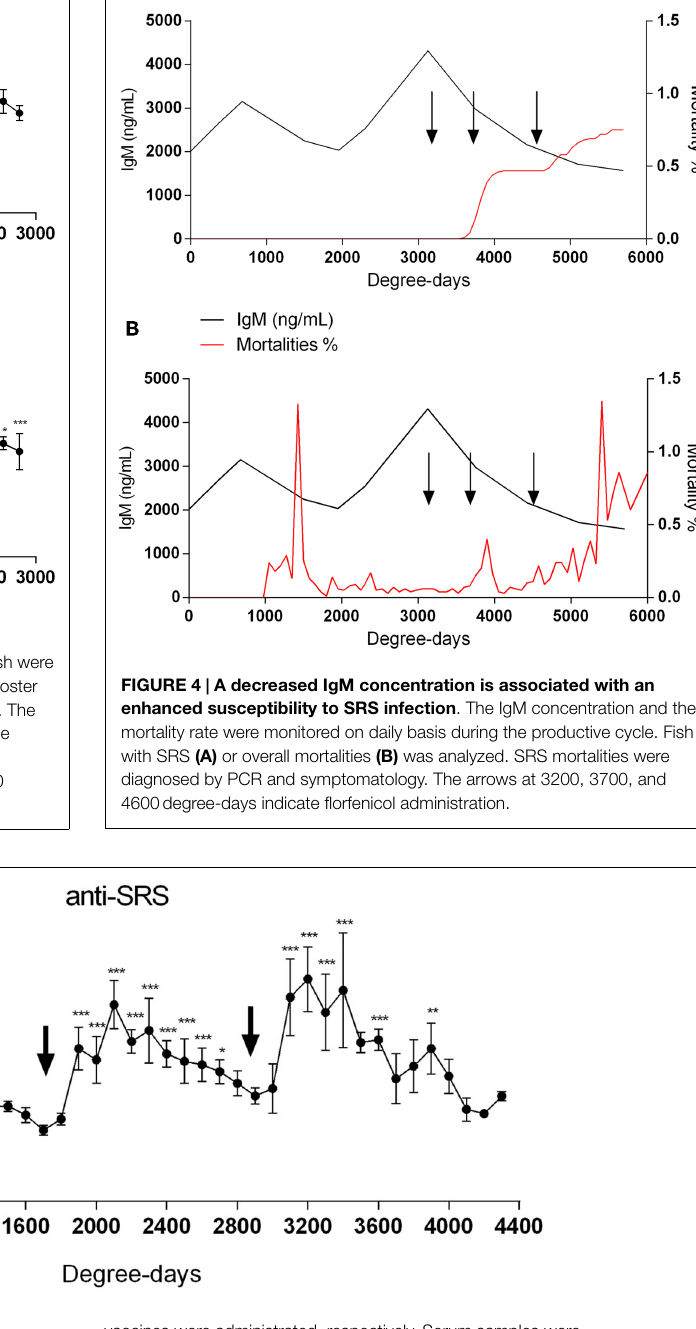
FIGURE 5 | Several oral immunizations are required to maintain a long-term protection against SRS . Salmonids from different aquaculture industries were first immunized with an injectable mono or polyvalent vaccine against SRS. The arrows at 1700 and 2900degree-days indicate the time-point where first and second oral